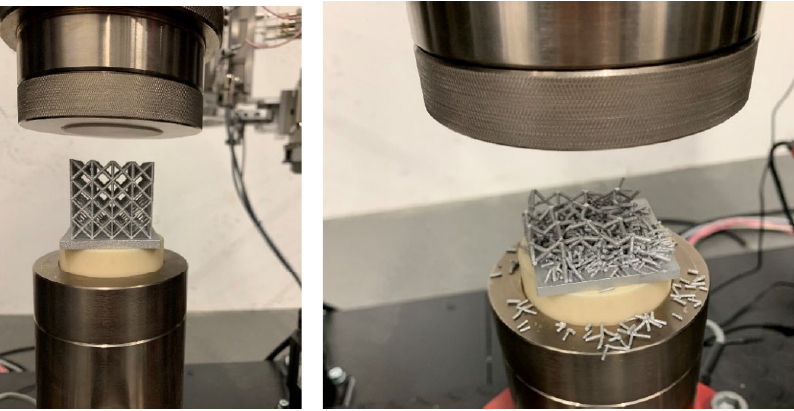
Figure 8. Lattice structure (T6) before ( left ) and after compression test ( right ).